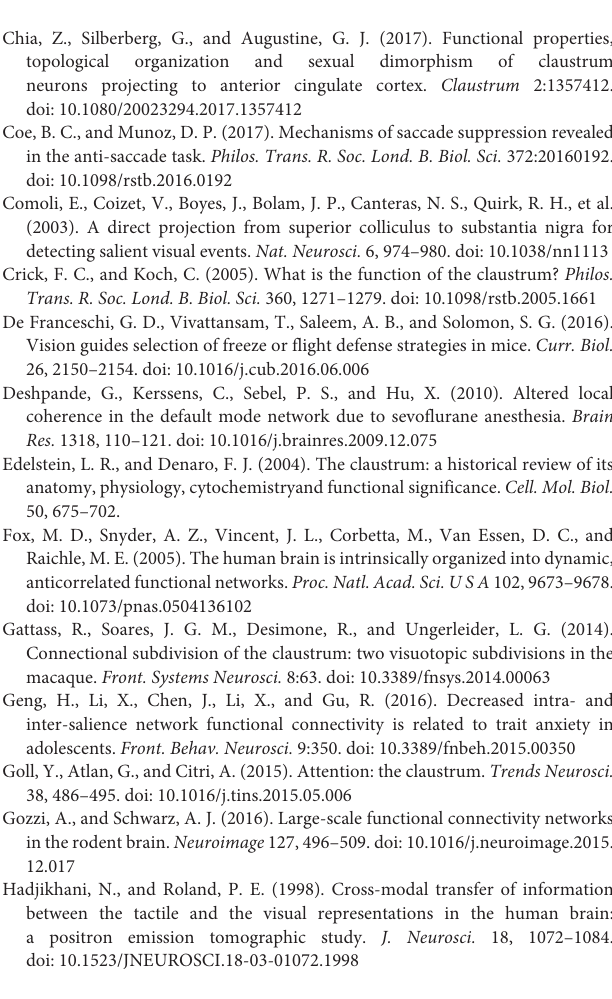
FIGURE S4 | Anatomical connectivity of central amygdala. (A) Projections from central nucleus of the amygdala (CeA) by contrast only weakly target the ventral striatum (VS) and bed nucleus of the stria terminalis (BNST) in the forebrain. (B) Summary diagram of afferents from the BLA, CeA, CLA and BNST. Scale bars: 1 mm in top row of panel (A) ; 400 µ m in bottom row of panel (A) ; 40 µ m in thalamus inset in bottom row of panel (A) . Data from the Allen Institute Mouse Connectivity Atlas (Oh et al., 2014). Image credit: Allen